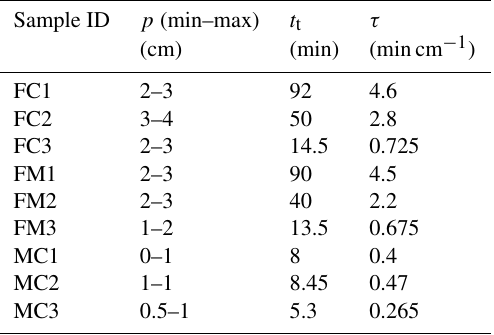
Table 2. Experimental results: observed ponding layer thickness p , experiment duration t t , and specific travel time τ . As for p , approx- imated lower and upper values are reported due to spatial hetero- geneity in this